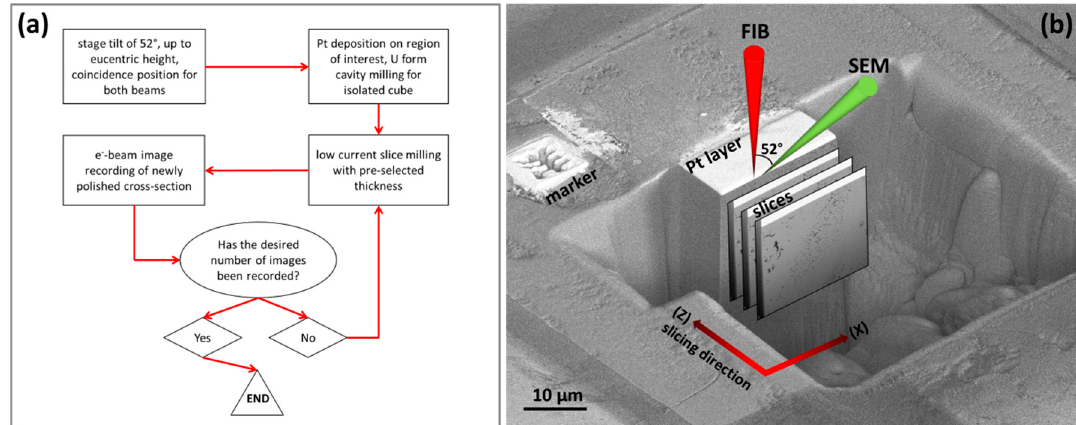
Figure 4. ( a ) A flow chart showing the serial sectioning procedure of FIB nano-tomography; ( b ) a schematic indication of one prepared region of interest for tomography technique in a FIB-SEM.